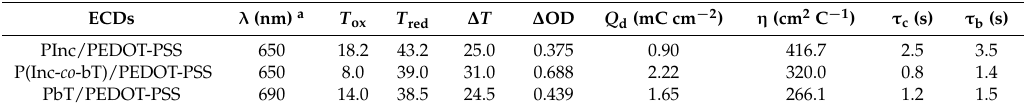
Table 4. Electrochemical optical contrast and coloration efficiencies of ECDs.